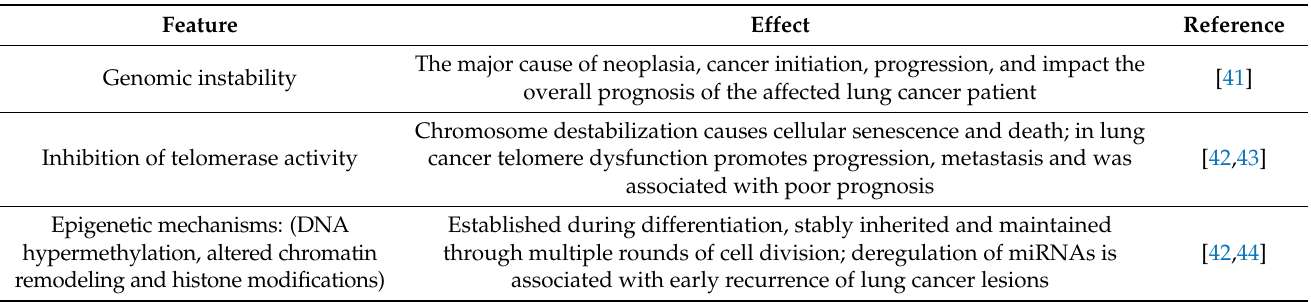
Table 2. Hallmarks of aging in lung